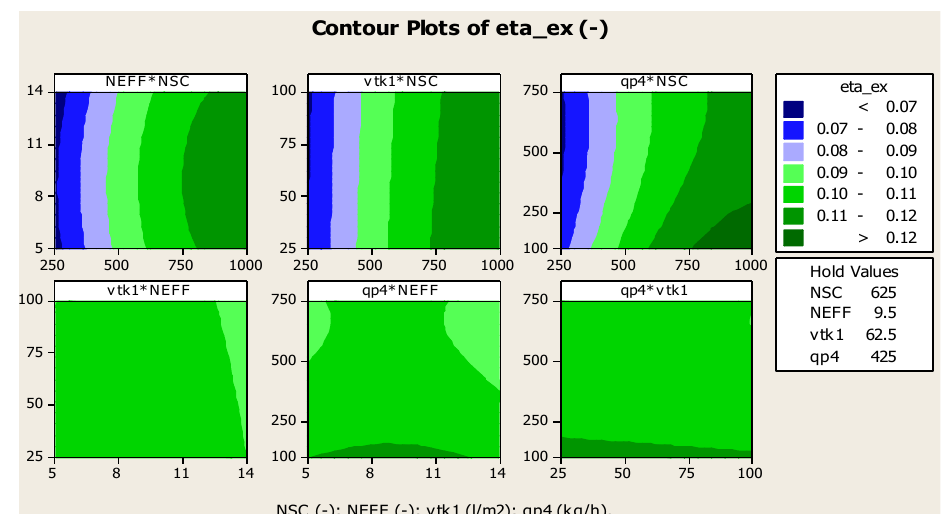
Figure 12. Contour plots of η ex